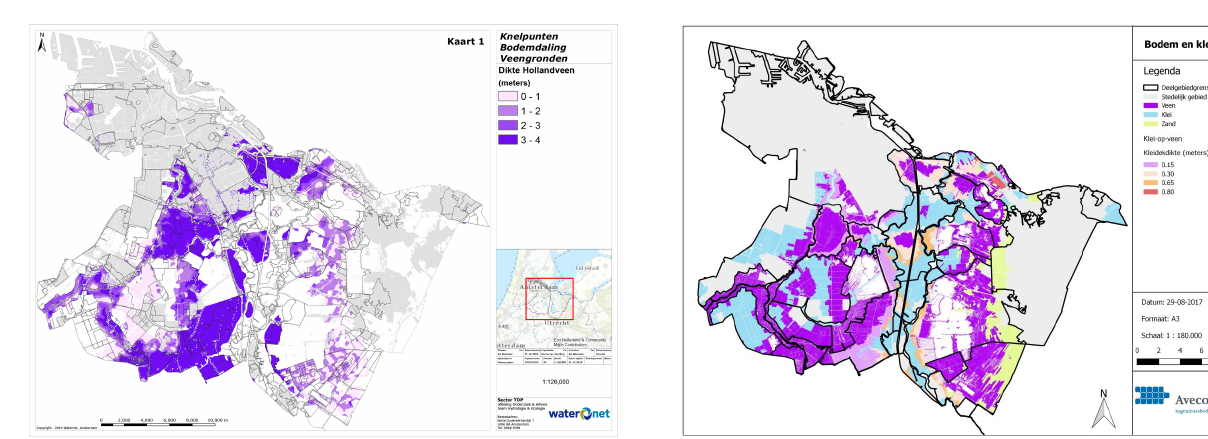
Figure 1. Water authority area Amstel Gooi and Vecht (with Ams- terdam middle-north/west of map) and the presence of peat soils. Gray/white is urban area or no peat soils. Dikte Hollandveen = Thickness peatlayer. Map and map-topography is a strongly modi- fied version of dutch GEOTOP map, published by TNO- Geologis- che Dienst Nederland, 2012.